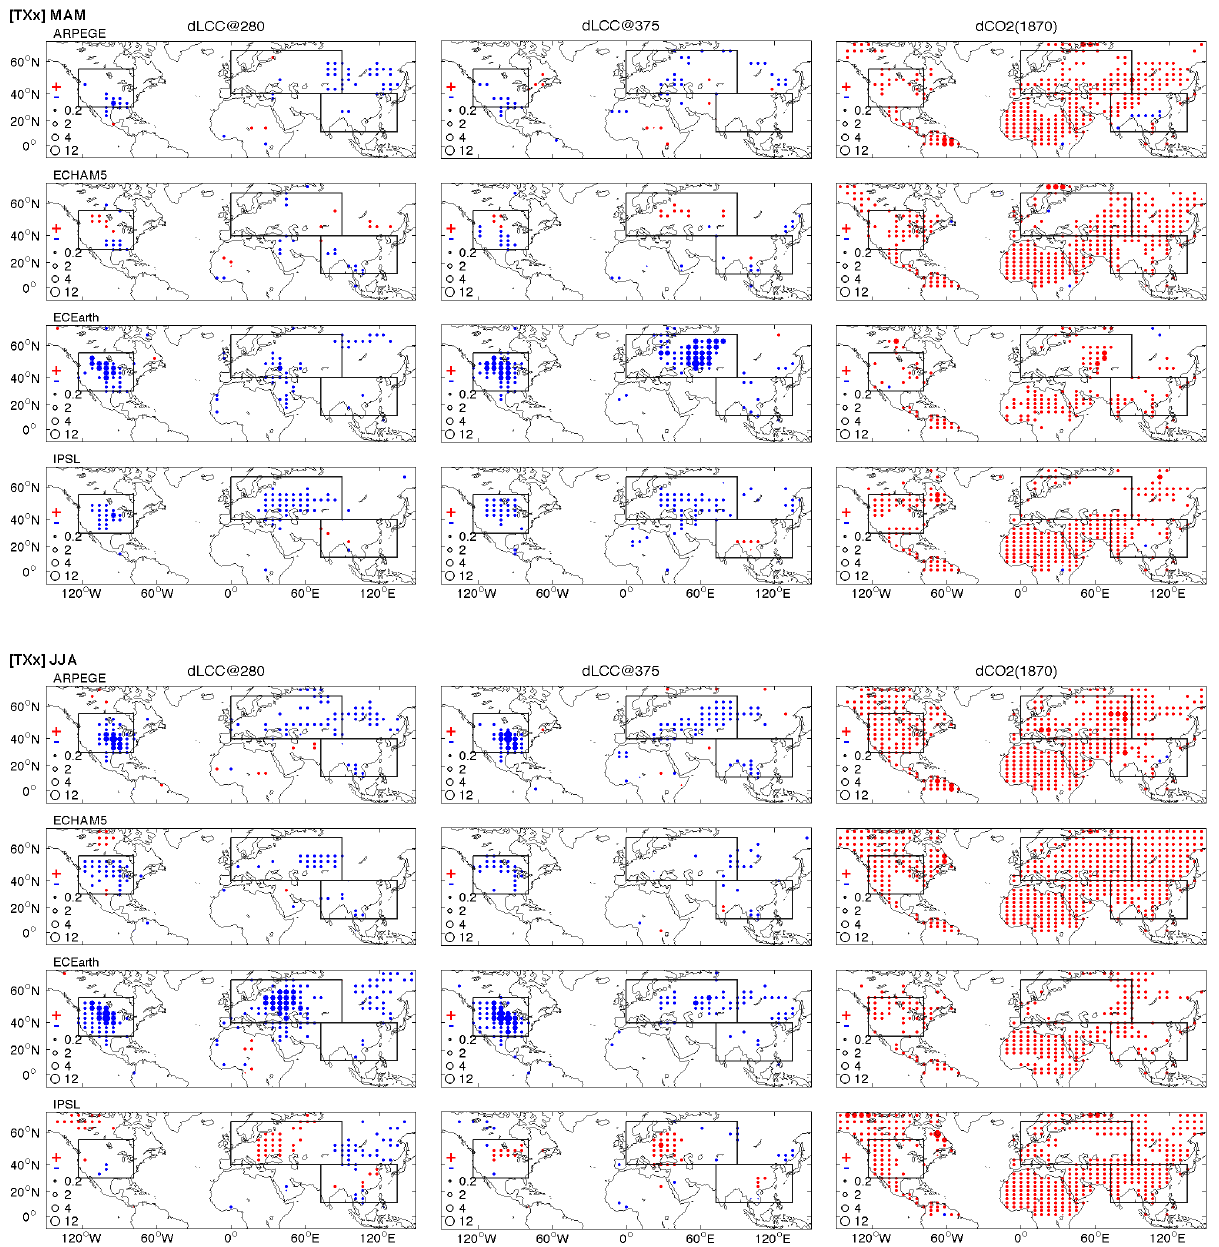
Fig. 4. As Fig. 2 but for the warmest seasonal daily maximum temperature (TXx, ◦ C). Only the grid points that are statistically significant at the 95% level using the two-tailed Kolmogorov–Smirnov test are shown (red for warming and blue for cooling). The magnitude of the change is indicated by the size of the